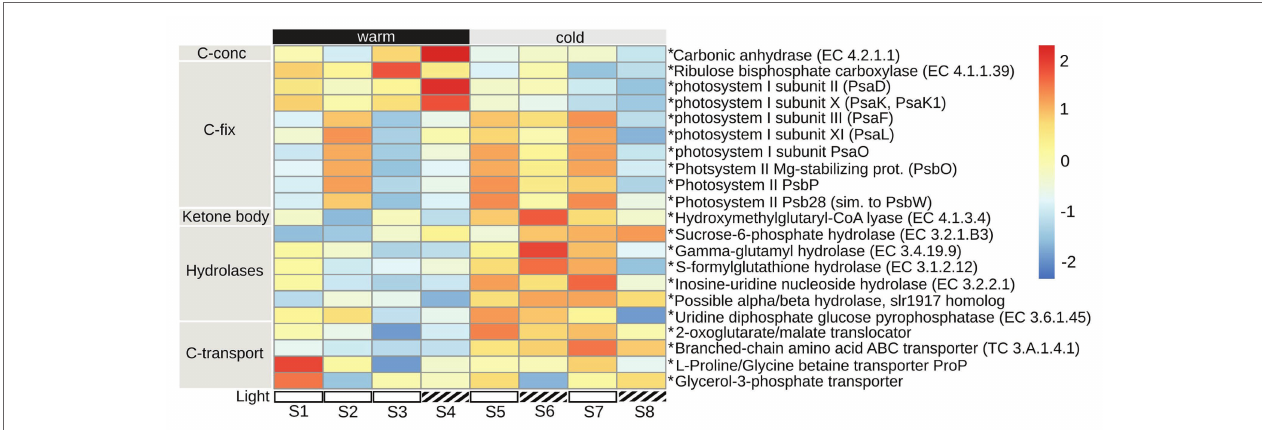
FIGURE 5 | Eukaryote gene expression (metatranscriptome) of mechanisms associated with carbon acquisition. Included are key enzymes representative of: carbon concentration (C-conc) and carbon fixation (C-fix), ketone body formation, hydrolases, and carbon transport. Heatmap shows the mean of triplicates per sampling date (S1–S8), of counts normalized to TPM and then square root transformed. Heatmap was made using R package pheatmap, with setting scale by “row.” Warm: 19.5 ± 0.89 ° C, cold: 12.4 ± 1.76 ° C (mean temperature per 24 h in PBR); Light: light reduction, open bar → natural light, striped bar → light reduced